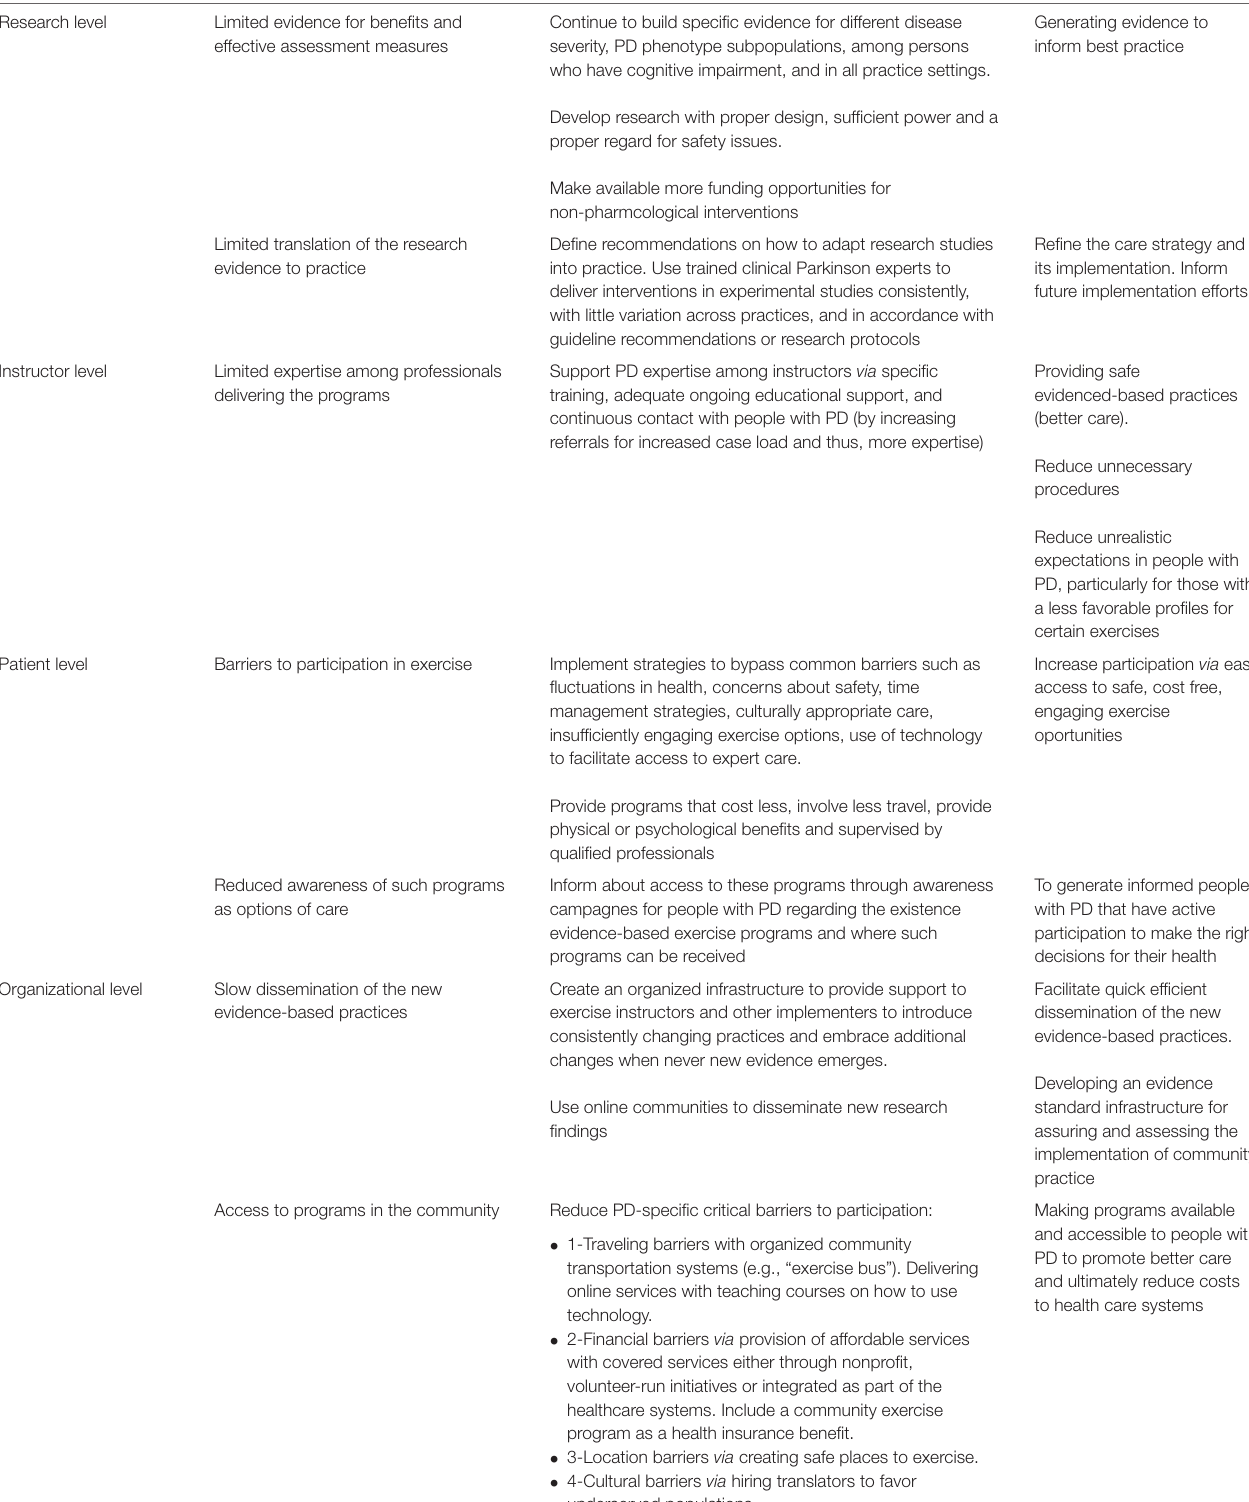
TABLE 1 | Summary of potential courses of action needed to improve quality community